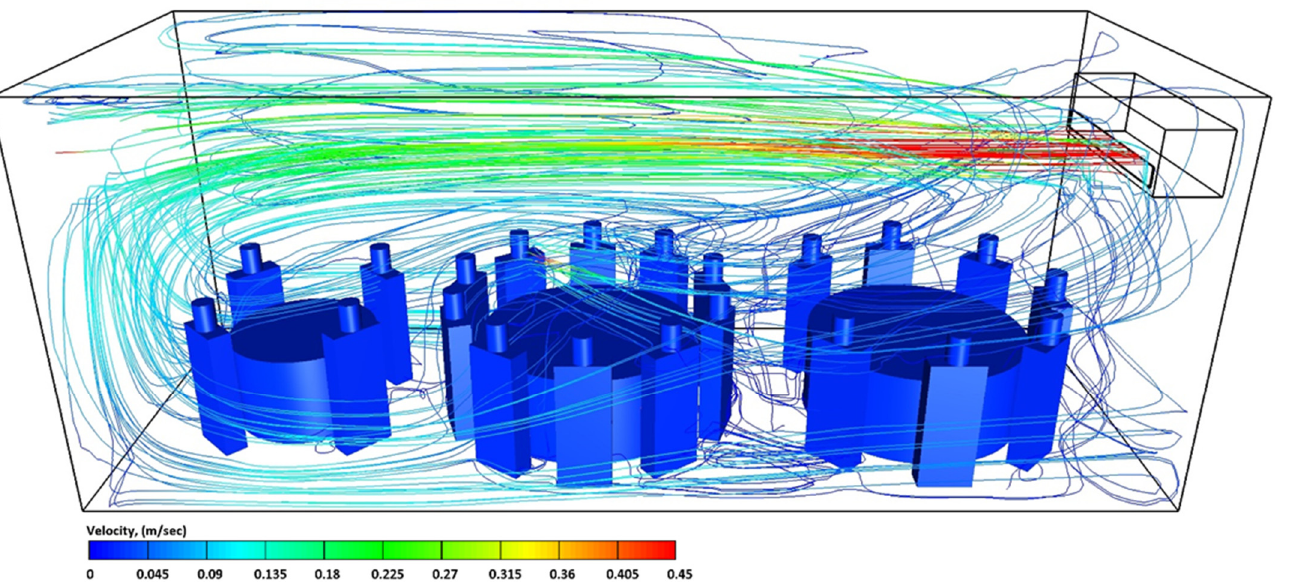
Figure 9. The predicted droplet concentrations per cubic meter exhaled from index case (T2C1) at t = 4500 s for case-5.